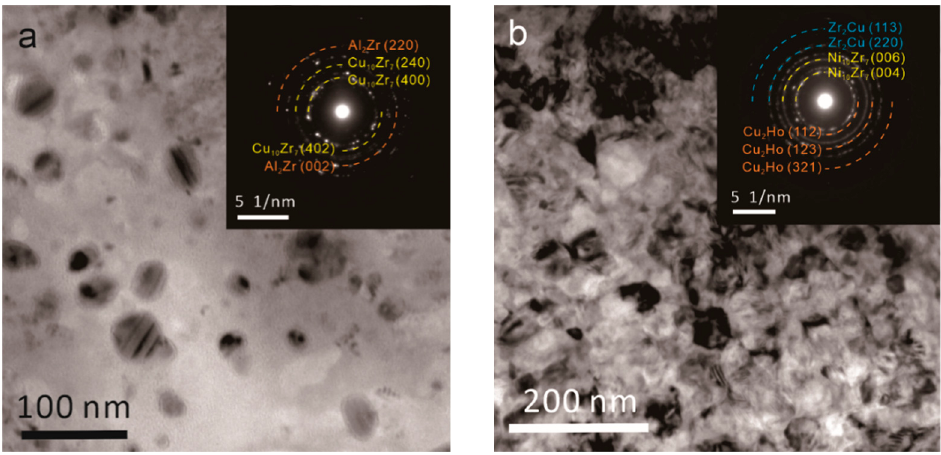
Figure 10. TEM images and the corresponding SAED results of ( a ) Zr54 BMG and ( b ) Zr48Ho6 BMG annealed at 500 °C for 20 min.